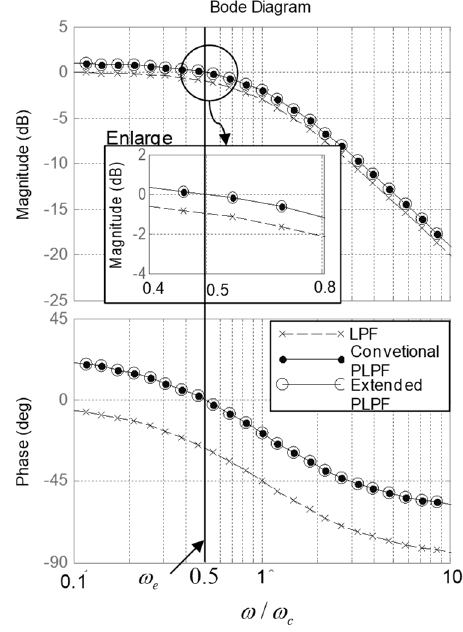
Figure 4. Bode plots of LPF and two PLPFs.